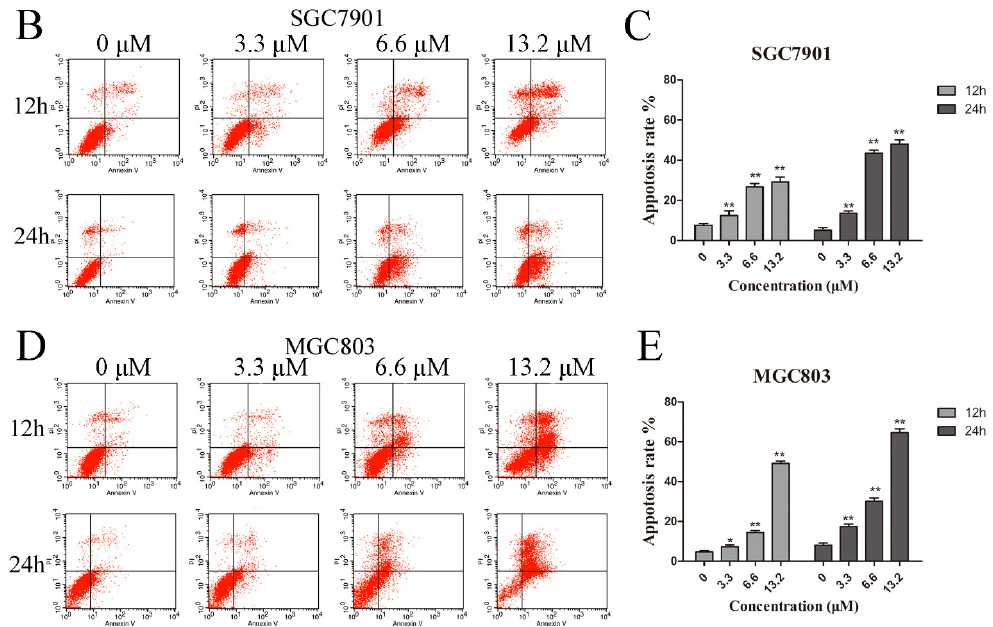
Figure 2. Zey induces apoptosis in SGC7901 and MGC803 cells. ( A ) Morphological changes of apoptosis were detected by Hoechst 33258 staining. Images are shown under a fluorescence microscope with a magnification of 200×. ( B , C ) Apoptosis of SGC7901 cells detected by the Annexin V ‐ FITC/PI staining test and the ratio of apoptotic cells. The data represented the means ± SD for triplicate determinations. * p < 0.05 and ** p < 0.01 vs. control cells. ( D , E ) Apoptosis of MGC803 cells detected by the Annexin V ‐ FITC/PI staining test and the ratio of apoptotic cells, including early apoptotic cells (lower right quadrant) and late apoptotic cells (upper right quadrant). The data represented the means ± SD for triplicate determinations. * p < 0.05 and ** p < 0.01 vs. control cells.